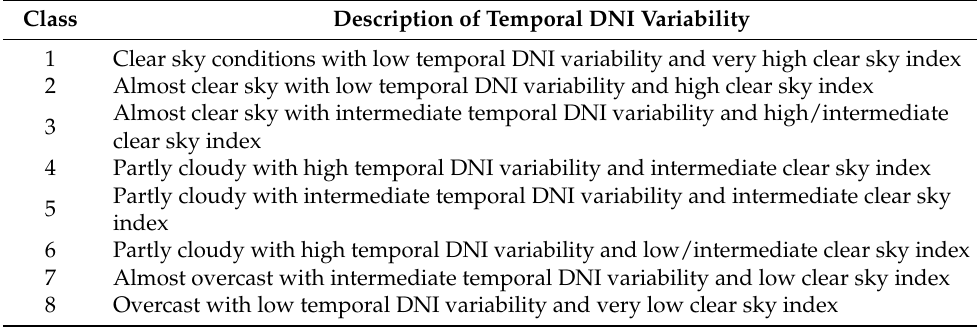
Table 8. Descriptions of the eight DNI variability classes by Nouri et al. [25].